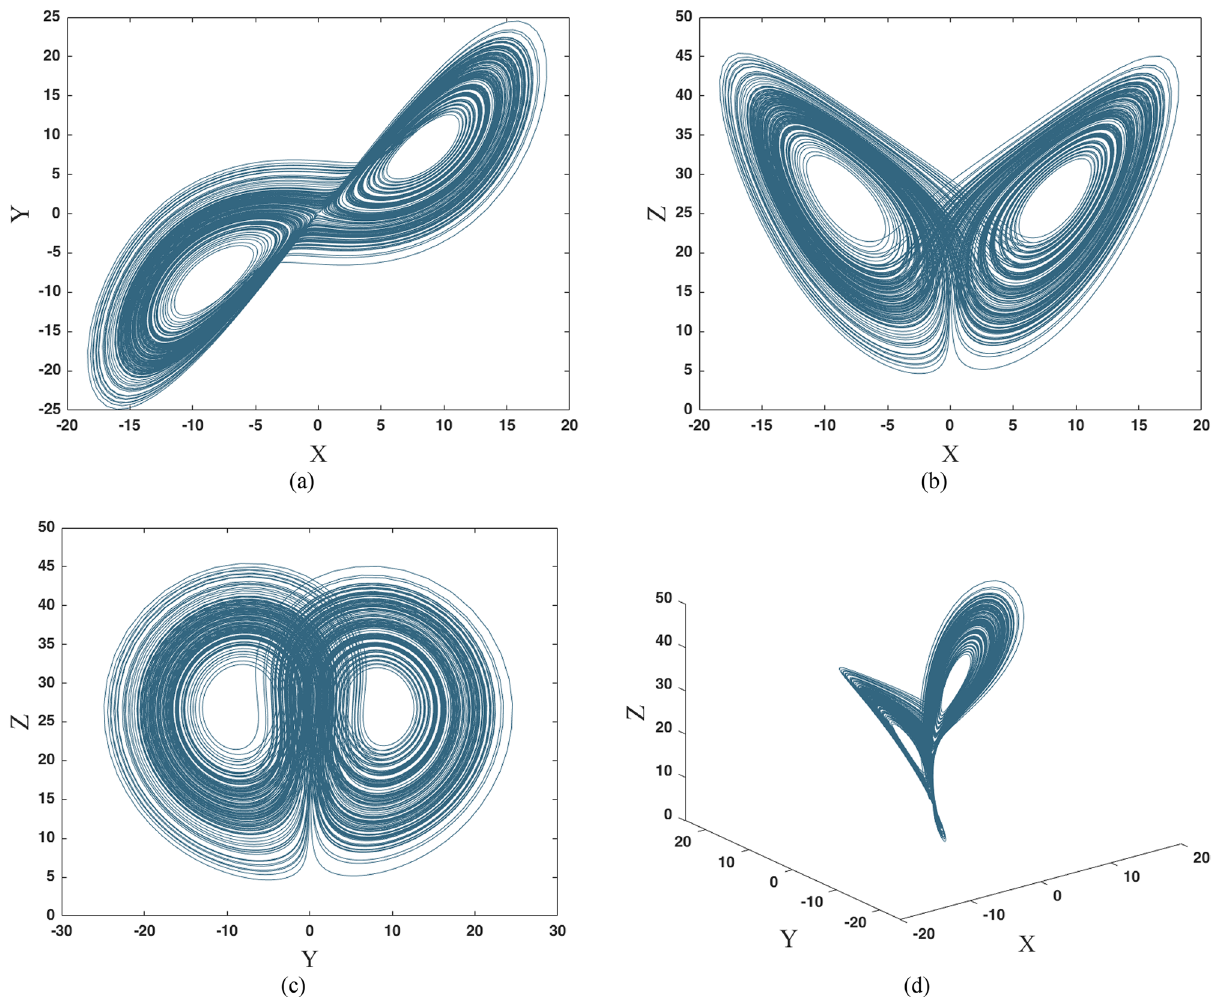
8 10 , β 28 , and initial conditions ρ 3 and = = = Y plane; ( b ) 2D projection − Z plane; ( d ) 3D chaotic −